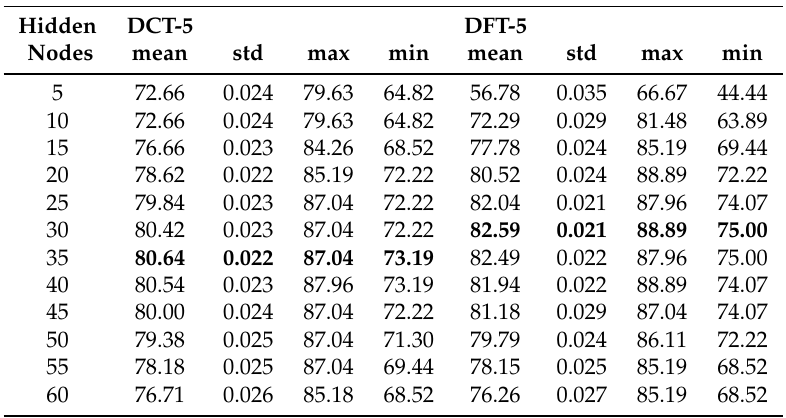
Table 2. The multi-class classification problem. Comparative summary of the network accuracy obtained for the best combinations of the DCT (five features) and the DFT (five features) depending on the hidden nodes used. For each feature set, there is an optimum number of hidden nodes providing the best results. In the table the bests accuracy results are highlighted in bold. The LOO-CV was performed and the experiments were repeated 1000